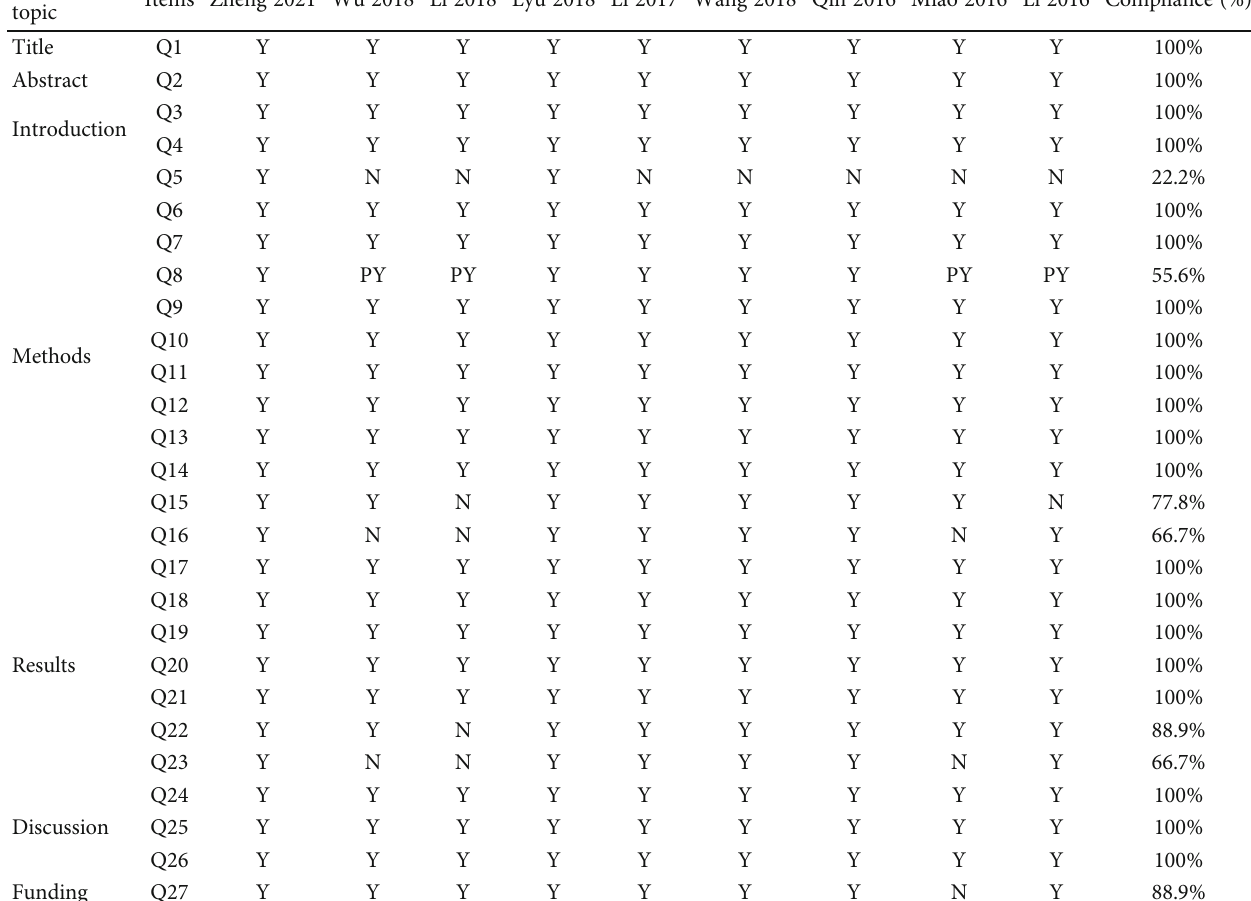
Table 2: Result of the PRISMA